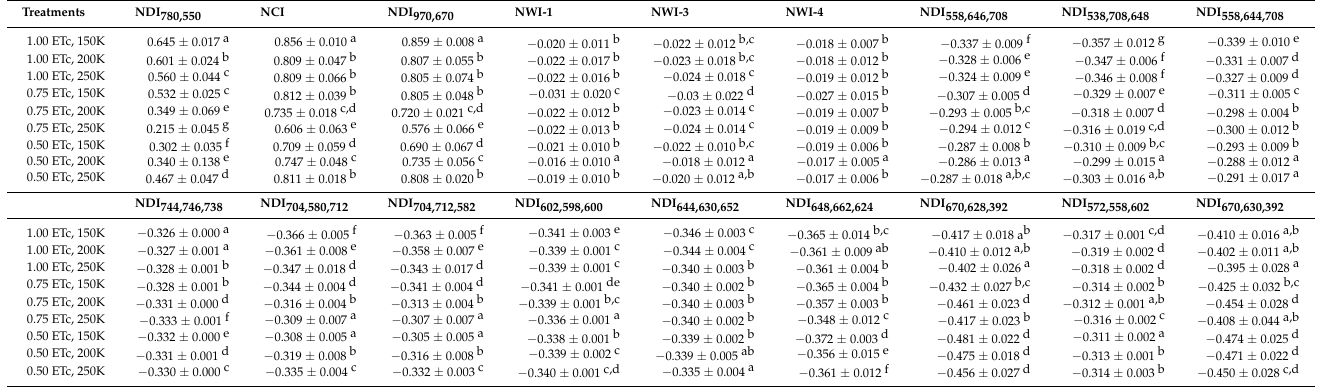
Table 5. Means and standard deviations of spectral reflectance indices under interaction effects of irrigation regime and potassium fertilization rate across spring and fall